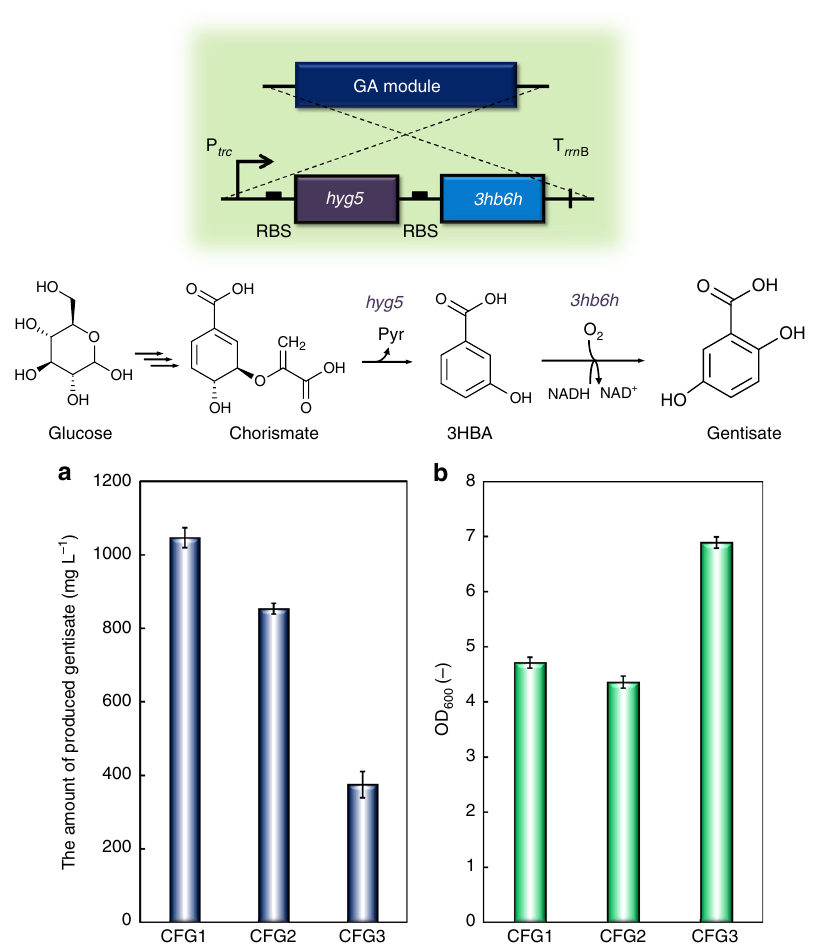
Fig. 2 Culture pro fi les of CFG1 – 3 after 72 h of cultivation. a The amount of produced gentisate. b OD 600 values. Data are presented as the mean ± standard deviation of three independent experiments ( n =